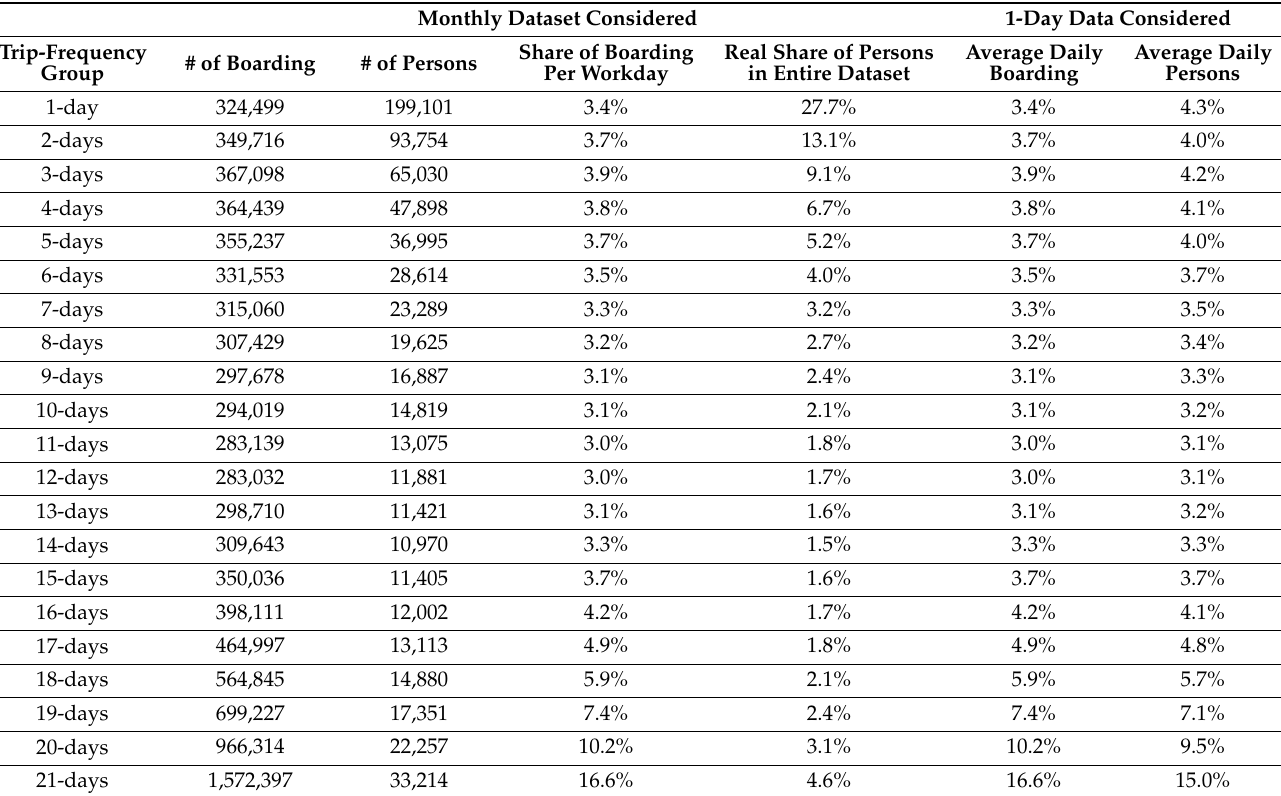
Figure A1. Share of card holders vs. share of boarding over a month. Table A2. Distribution of users and boarding over workdays considering 1-month data vs. one-data according to their trip